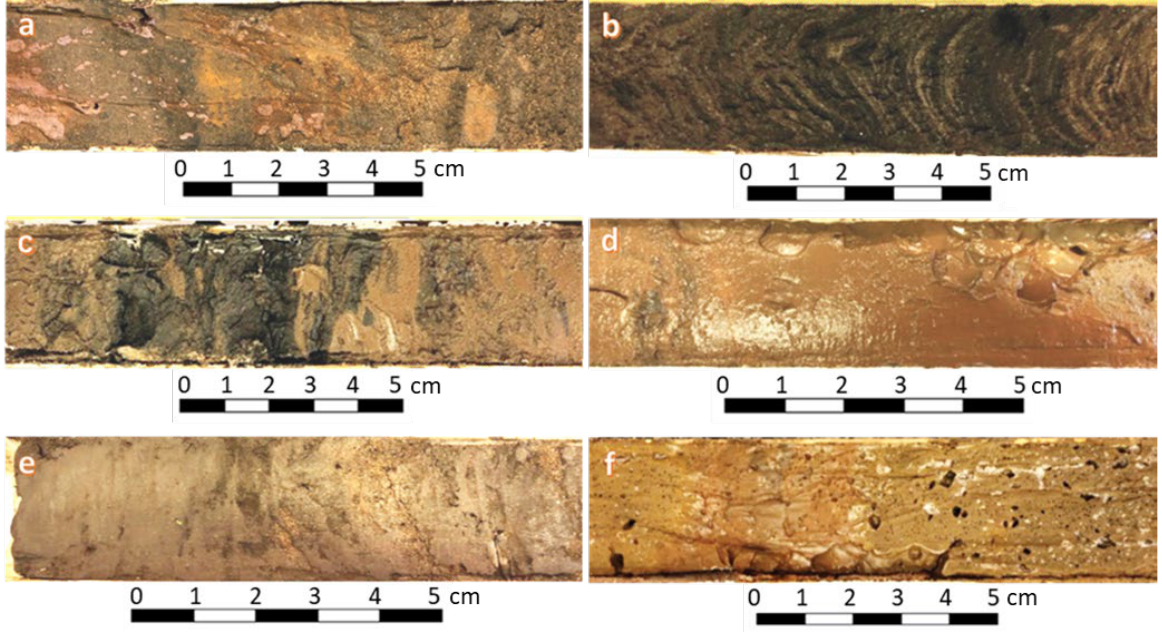
Figure 3. Photography of part of the sampled cores: ( a )—M2 section; ( b )—P3 section; ( c )—P8 section; ( d )—P16 section; ( e )—P19 section; ( f )—P22 section .